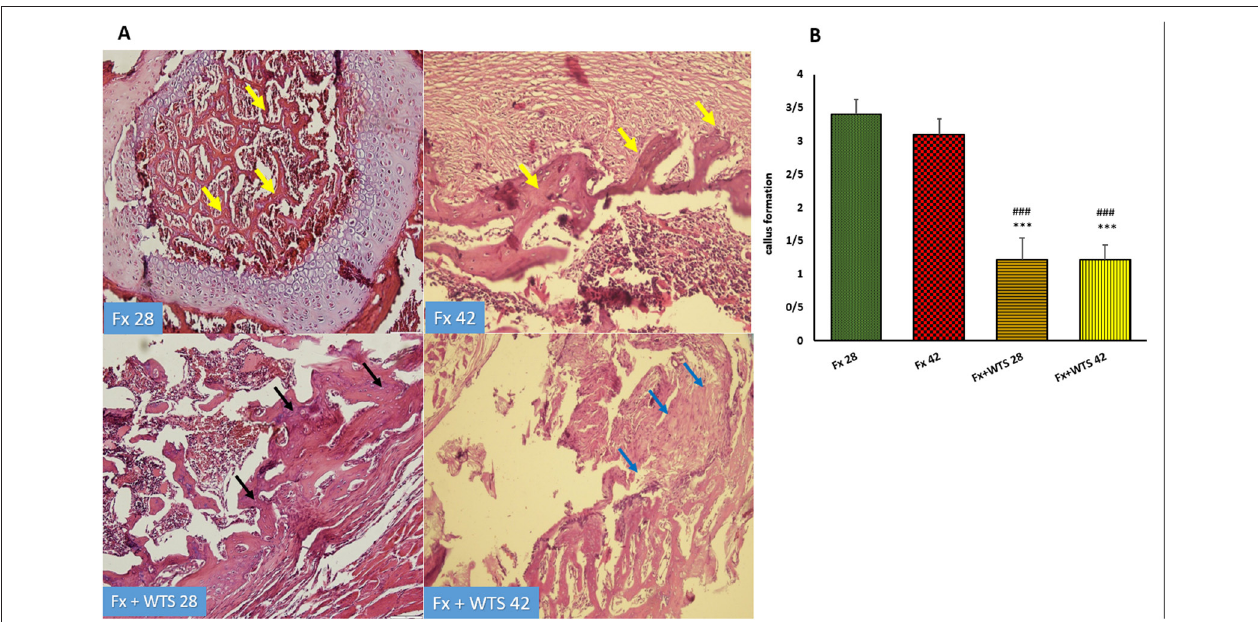
FIGURE 10 | (A) Pathological representation of callus formation. In the Fx 28 group, fractures show bone blades that are properly formed and have regular bone marrow between them (yellow arrows). In the Fx 42 group, callus tissue is observed that has formed regularly (yellow arrows). In the Fx + WTS 28 group, pre-callus tissue is still observed, and the callus is irregularly formed and weakly shaped (black arrows). In the Fx + WTS 42 group, fibrotic non-union is observed (blue arrows). (B) The quantification of pathologic findings regarding callus formation in experimental groups. Fx 28: group subjected to room air for 28 days after surgery and a femoral bone fracture, Fx 42: group subjected to room air for 42 days after surgery and a femoral bone fracture, Fx + WTS 28: group subjected to WTS for 28 days after surgery and femoral bone fracture, Fx + WTS 42: group subjected to WTS for 42 days after surgery and femoral bone fracture. The results are presented as mean ± SEM, n = 10. *** P < 0.001 vs. Fx 28; ### P < 0.001 vs. Fx